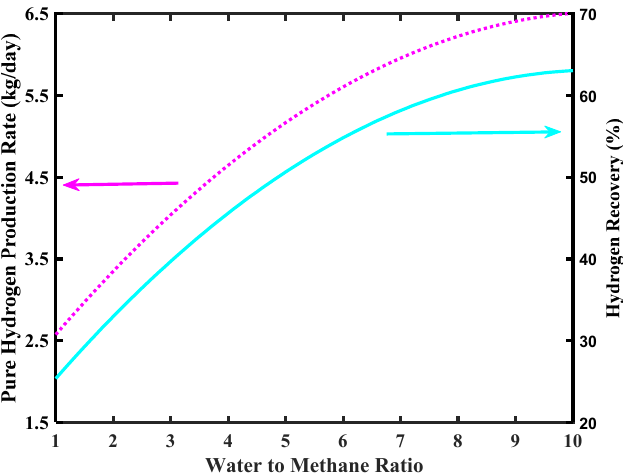
Figure 10. Pure H 2 production rate and hydrogen recovery versus MR pressure, Pd-Ag membrane thickness = 50 µm, water to methane ratio = 2.5, and inlet temperature = 500 °C.